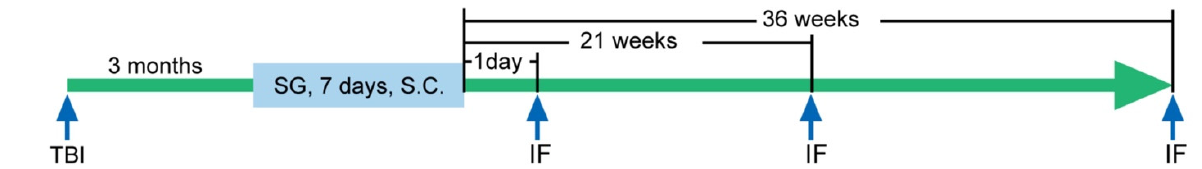
Figure 1. A schematic flowchart of the experiment. The mice were treated with SCF + G-CSF (SG) for 7 days at 3 months after TBI. The immunofluorescence (IF) staining on brain sections was performed at 1 day, 21 weeks, and 36 weeks post-treatment, respectively.